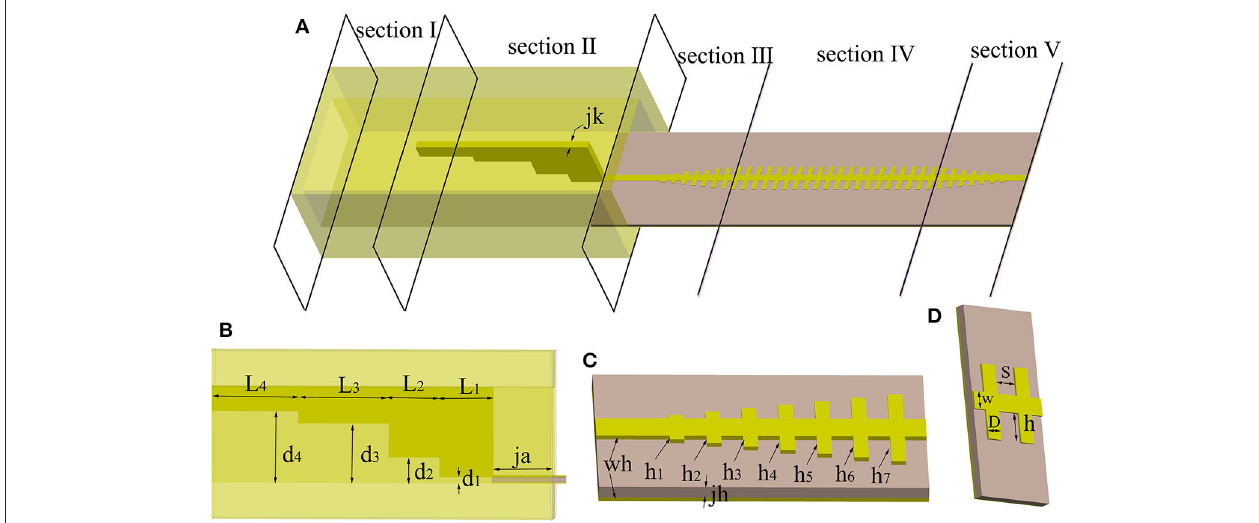
FIGURE 1 | (A) The proposed conversion between the rectangular waveguide and the spoof SPPs TL. (B) Section II, the detail and geometric parameters of the stepped ridge. (C) Section III, the detail and geometric parameters of the seven gradient grooves. (D) Two unit cells in section